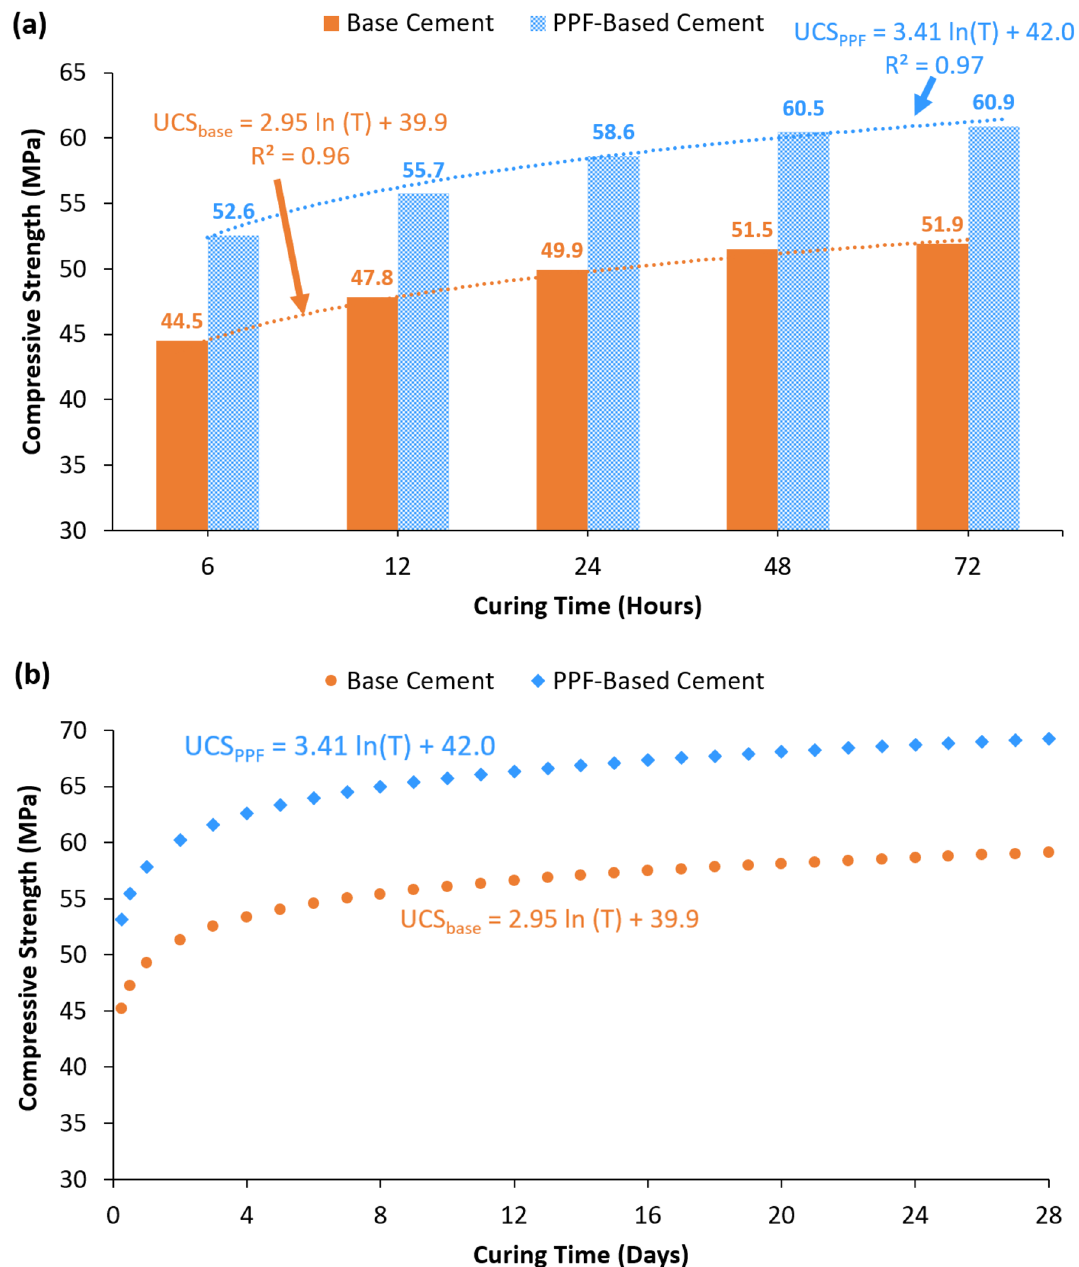
Fig. 4 Compressive strength for the polypropylene and base specimens at various curing times. a The findings of the compressive strengths dur- ing early curing times. b The anticipated variations in compressive strength over 4